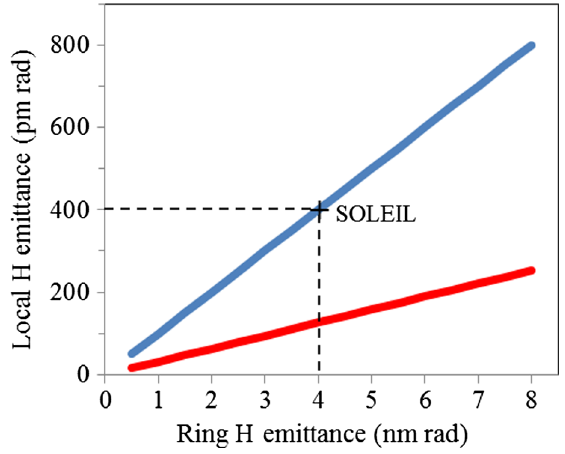
FIG. 1. Apparent local horizontal ( H ) emittance attained with the Chao-Raimondi scheme for the SOLEIL case as a function of the original horizontal ( H ) ring emittance and the emittance coupling: 1% (blue) and 0.1%